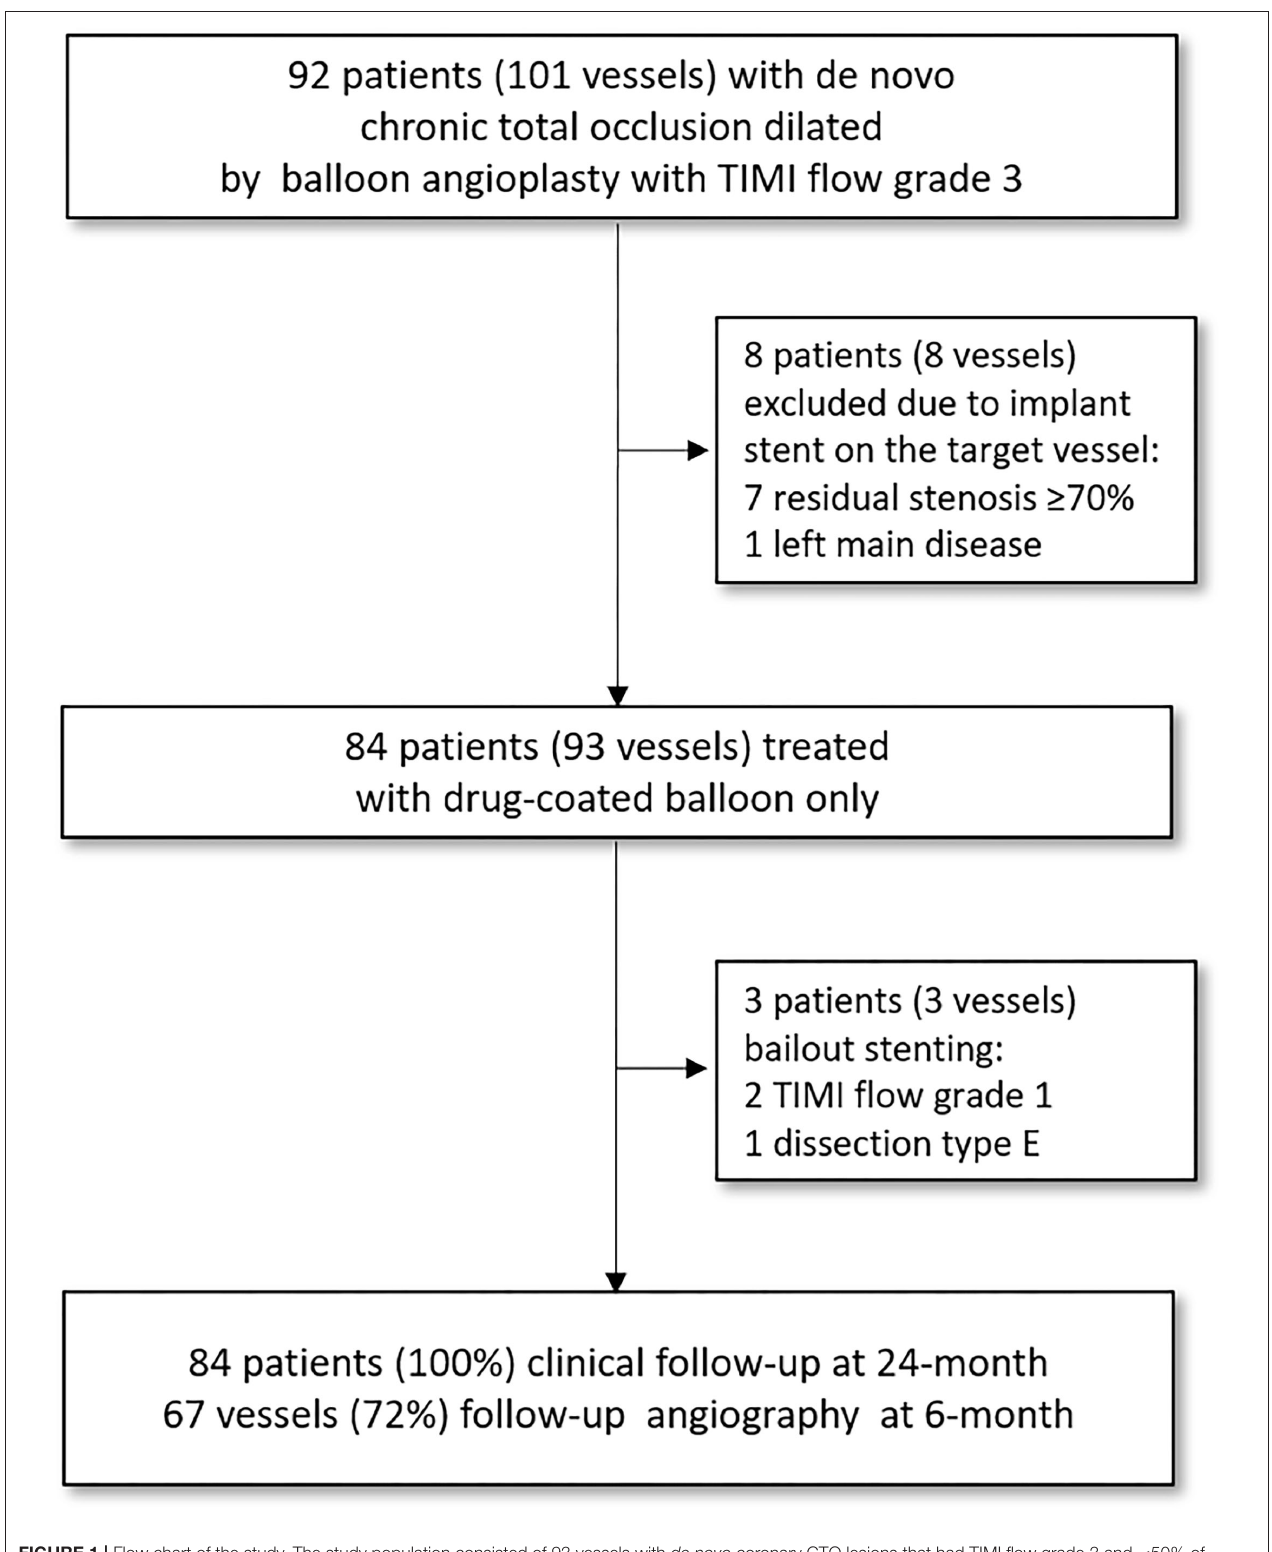
FIGURE 1 | Flow chart of the study. The study population consisted of 93 vessels with de novo coronary CTO lesions that had TIMI flow grade 3 and < 50% of residual stenosis following pre-dilatation balloon angioplasty and were successfully treated with DCB without requiring stent implantation. All patients were followed clinically, and angiographic follow-up was performed in 72% of the vessels under study. CTO, chronic total occlusion; TIMI, thrombolysis in myocardial infarction.